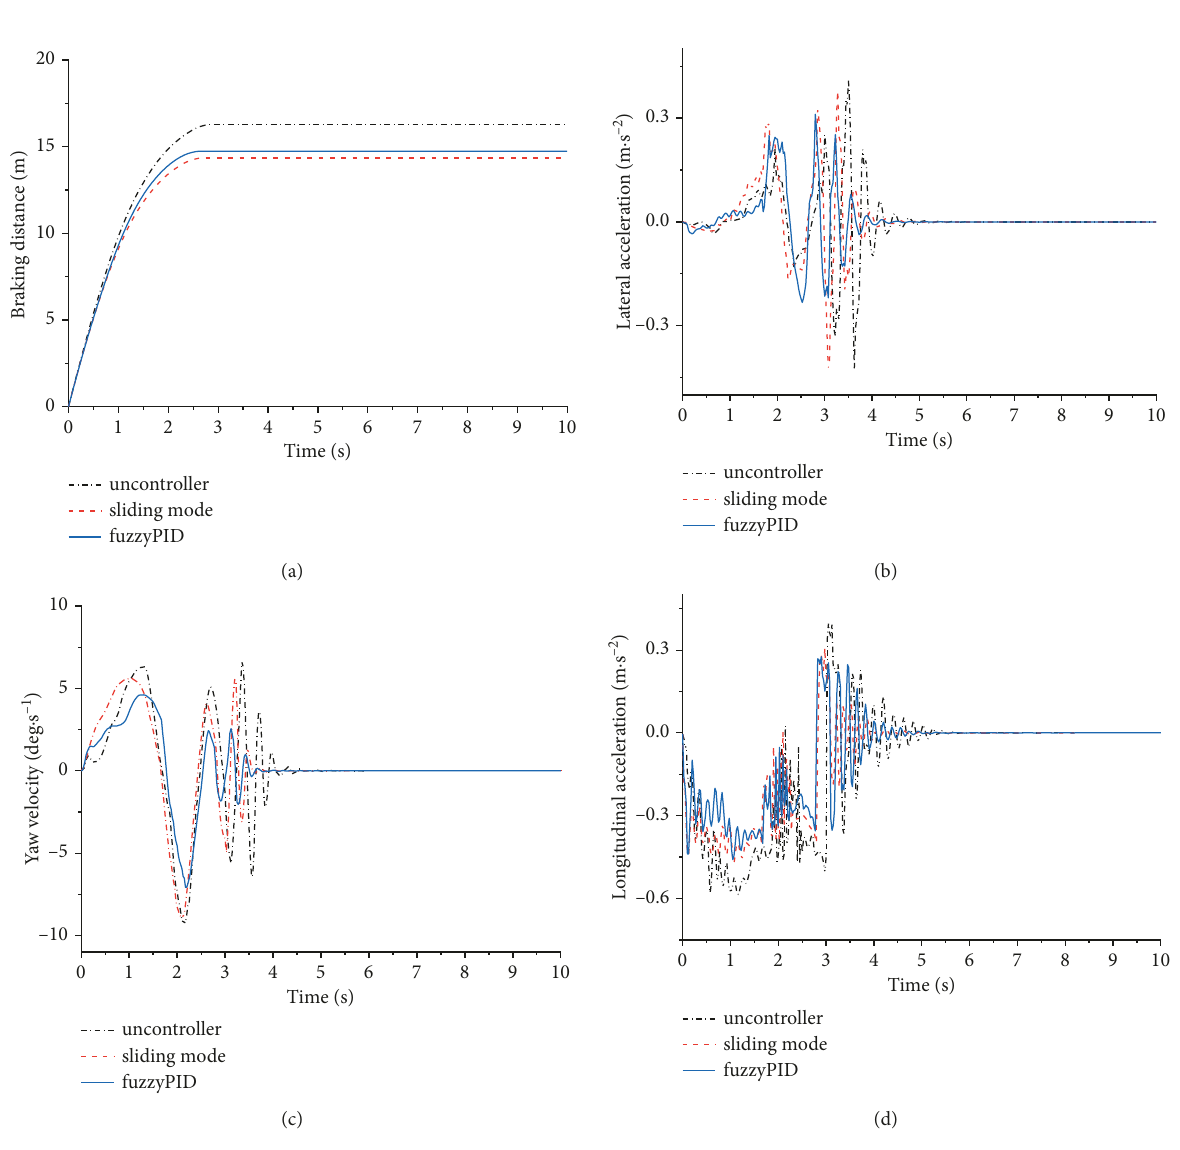
Figure 20: Simulation diagram of curve driving with long downhill braking efficiency of 70% at u � 0.75. (a) Braking distance. (b) Lateral acceleration. (c) Yaw velocity. (d) Longitudinal